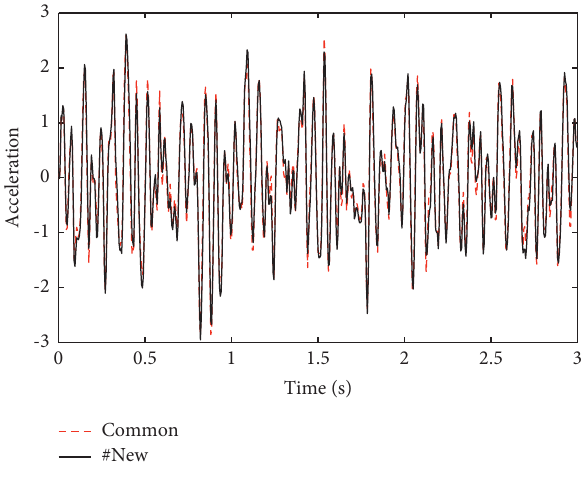
Figure 5: Body acceleration.